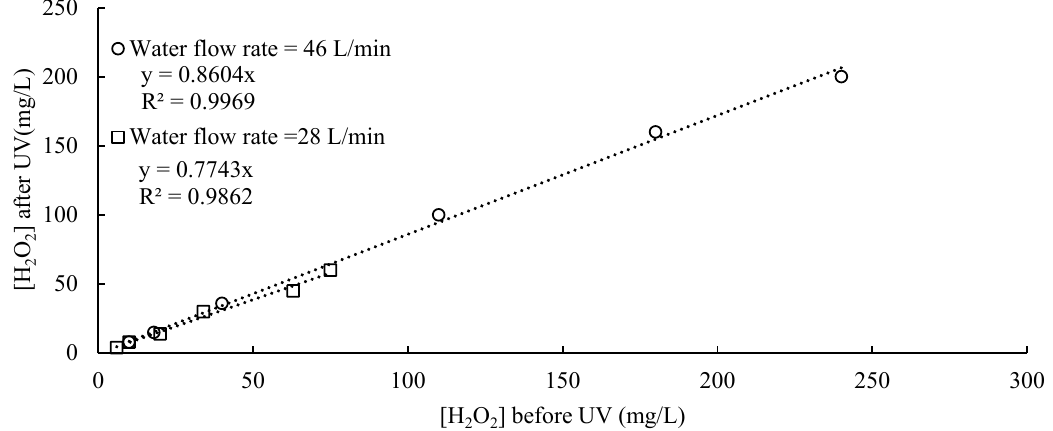
Figure 6. The concentration of H 2 O 2 before UV chamber versus its concentration after UV chamber: Water II, [sulfolane] = 9.5 mg/L.